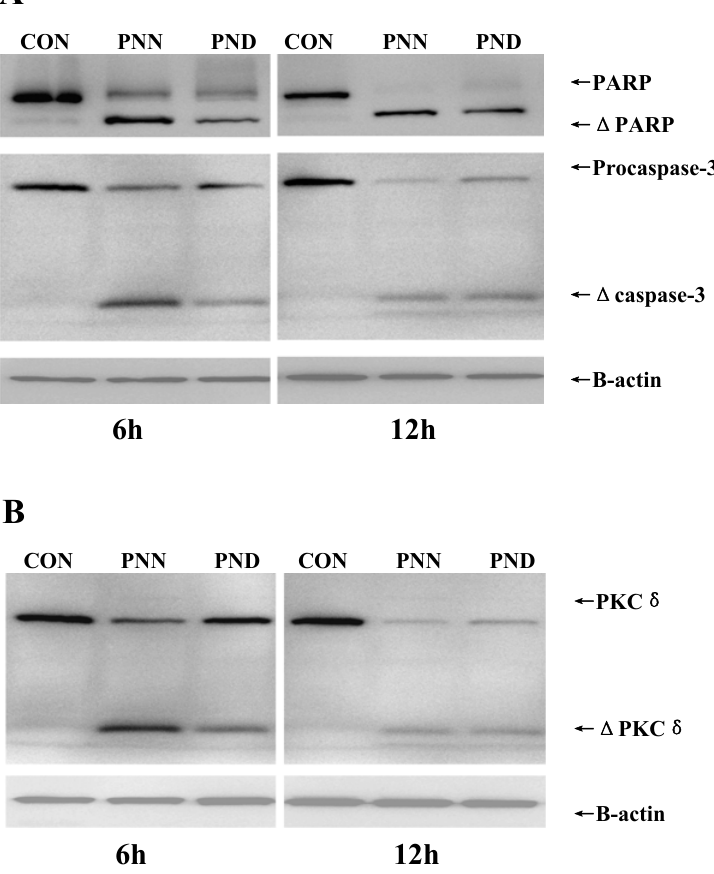
Figure 6. Expression levels of apoptosis-related proteins after the treatment of 5 μ M PNN and 30 μ M PND for 6 h and 12 h in HL60 cells. Proteins were analyzed by SDS-PAGE and western blot using caspase-3, PARP ( A ) and PKC δ ( B ) antibodies. β -actin was used as a control for loading. The presented blot was representative of three independent